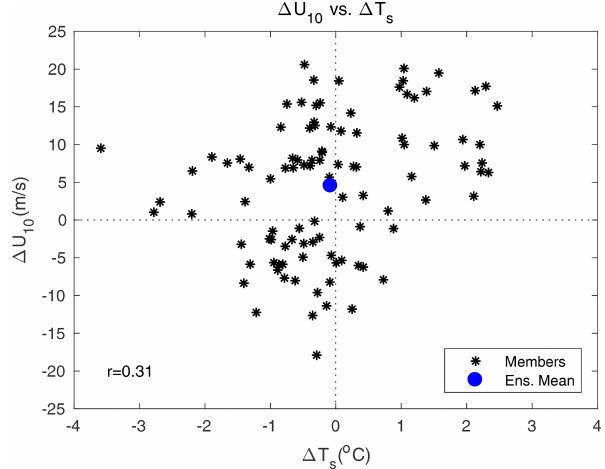
Figure 7. Post-Krakatau, DJF, zonal mean, zonal wind anomalies at 10hPa and 60 ◦ N ( (cid:49)U 10 ) in the 100-member MPI ensemble vs. the Eurasian surface temperature anomalies ( (cid:49)T s ). The blue dot shows the ensemble mean, and the black asterisks show individual mem-